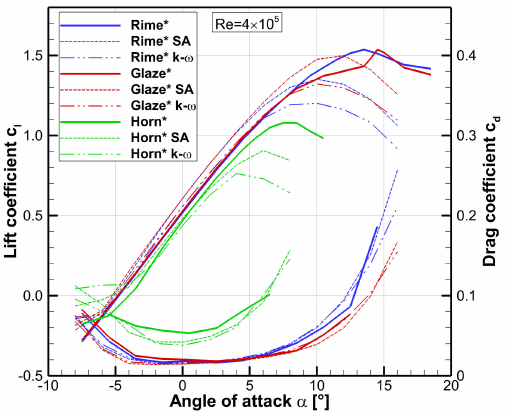
Figure 11. Comparison between numerical and experimental results of lift and drag for the LEWICE ice shapes for Re = 4 × 10 5